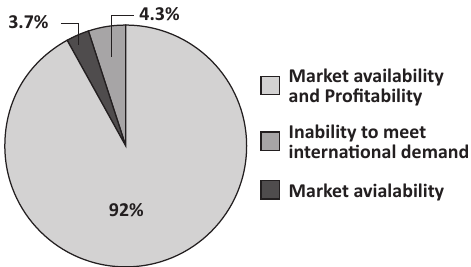
FigUre 1. Choice of market for the sale of furniture products by the manufacturing firms